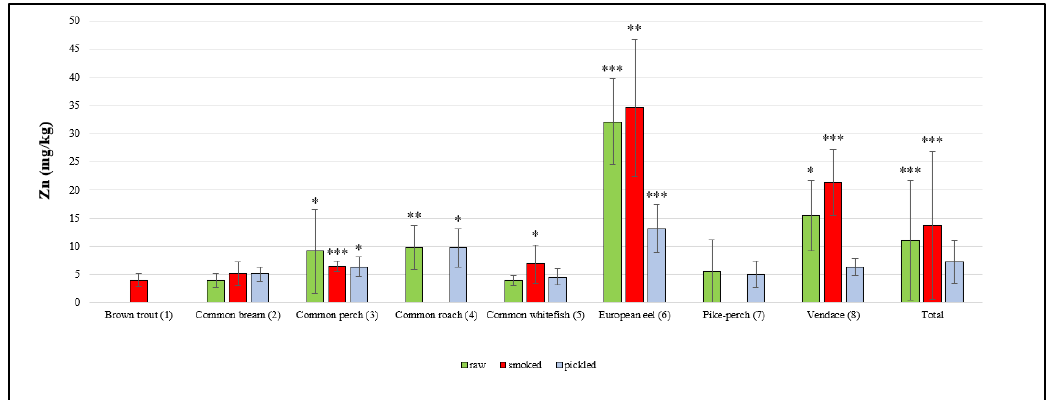
Figure 1. Zn concentration in raw, smoked and pickled freshwater fish product samples (mg/kg).